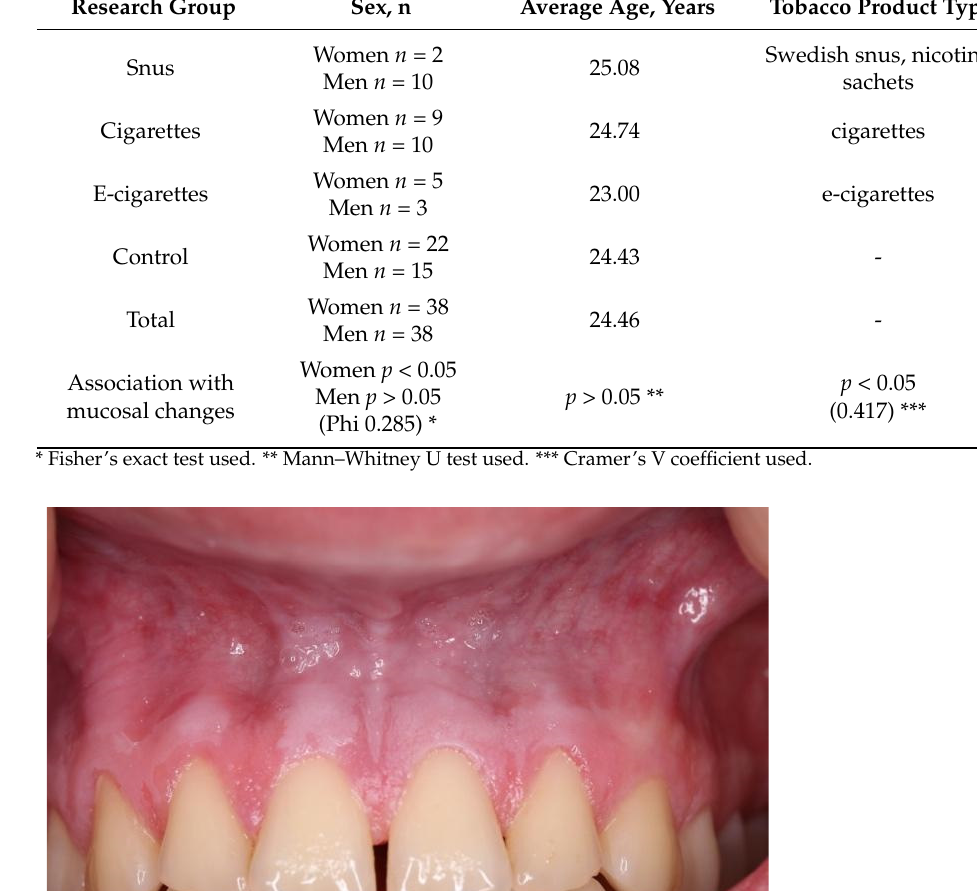
Table 2. Association between mucosal changes and average age, sex, and tobacco product type used. Research Group Sex, n Average Age, Years Tobacco Product Type